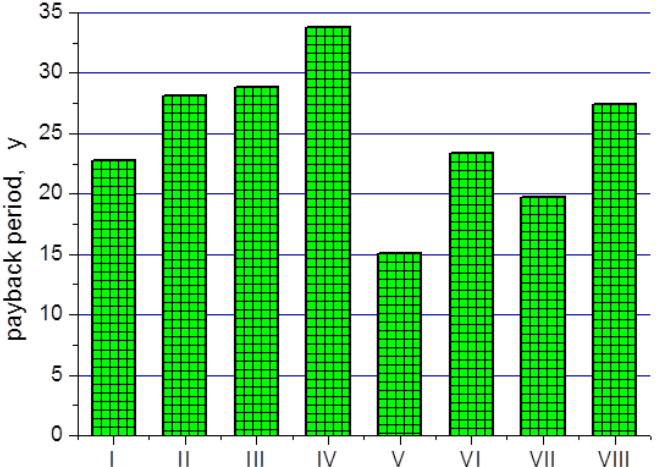
Figure 4. Payback time for each option analyzed (methods I to VIII according to Table 1).